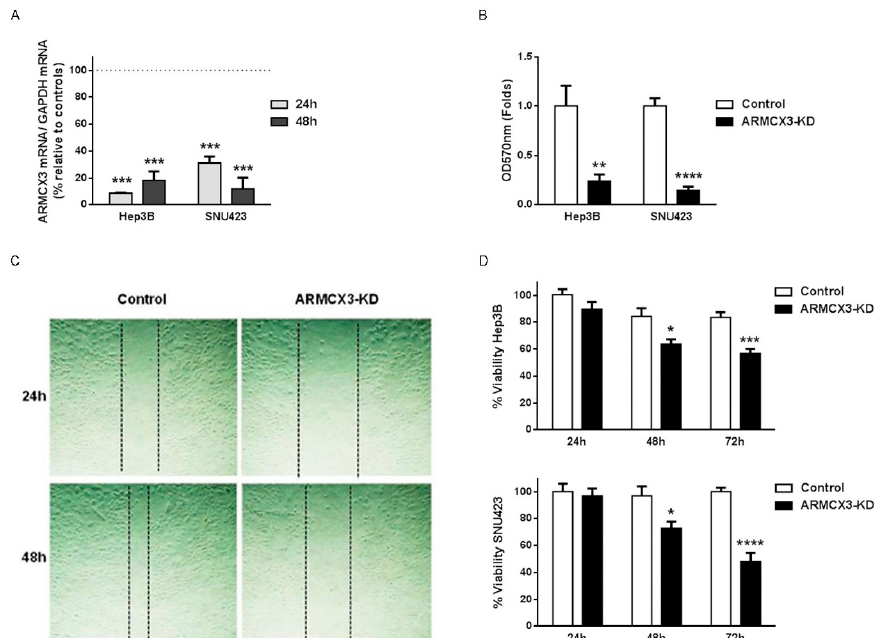
Figure 5. ARMCX3 deletion reduces the viability, clonality and invasivity of HCC cells in vitro. ( A ) ARMCX3 mRNA levels in Hep3B and SNU423 HCC cells 24 h and 48 h after transfection with ARMCX3 siRNA versus negative control siRNA (top dotted line), **** p ≤ 0.0001. ( B ) Colony ‐ forming assays performed with Hep3B and SNU423 cells transfected with negative control siRNA (Control) or ARMCX3 siRNA. ( C ) Representative images of wound ‐ healing assay results obtained using control and ARMCX3 ‐ KD Hep3B cells. Magnification: 10× ( D ) Percentage viability of control and ARMCX3 ‐ KD Hep3B and SNU423 cells at 24 h, 48 h and 72 h after transfection. Bars show the means ± SEM of three independent cell culture points. Two ‐ Way ANOVA test with Dunnett post hoc correction was used. * p ≤ 0.05, ** p ≤ 0.01, *** p ≤ 0.001 and **** p ≤ 0.0001.